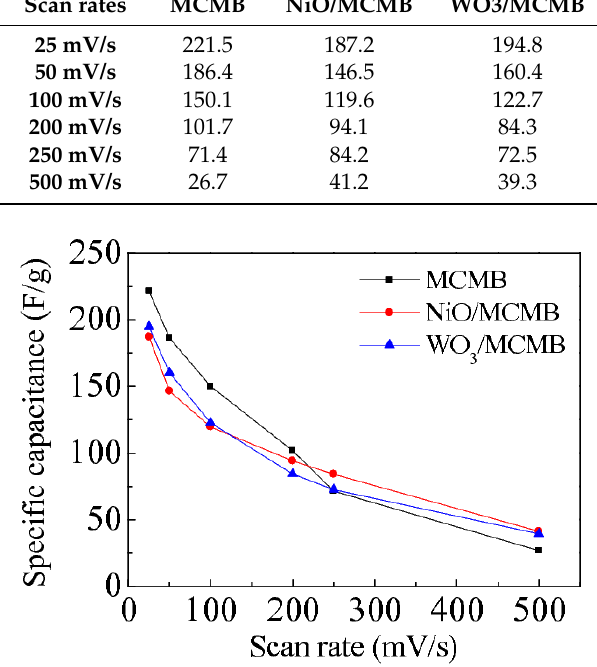
Figure 6. Specific capacitances of the carbon electrodes and the composite electrodes at various scan rates.